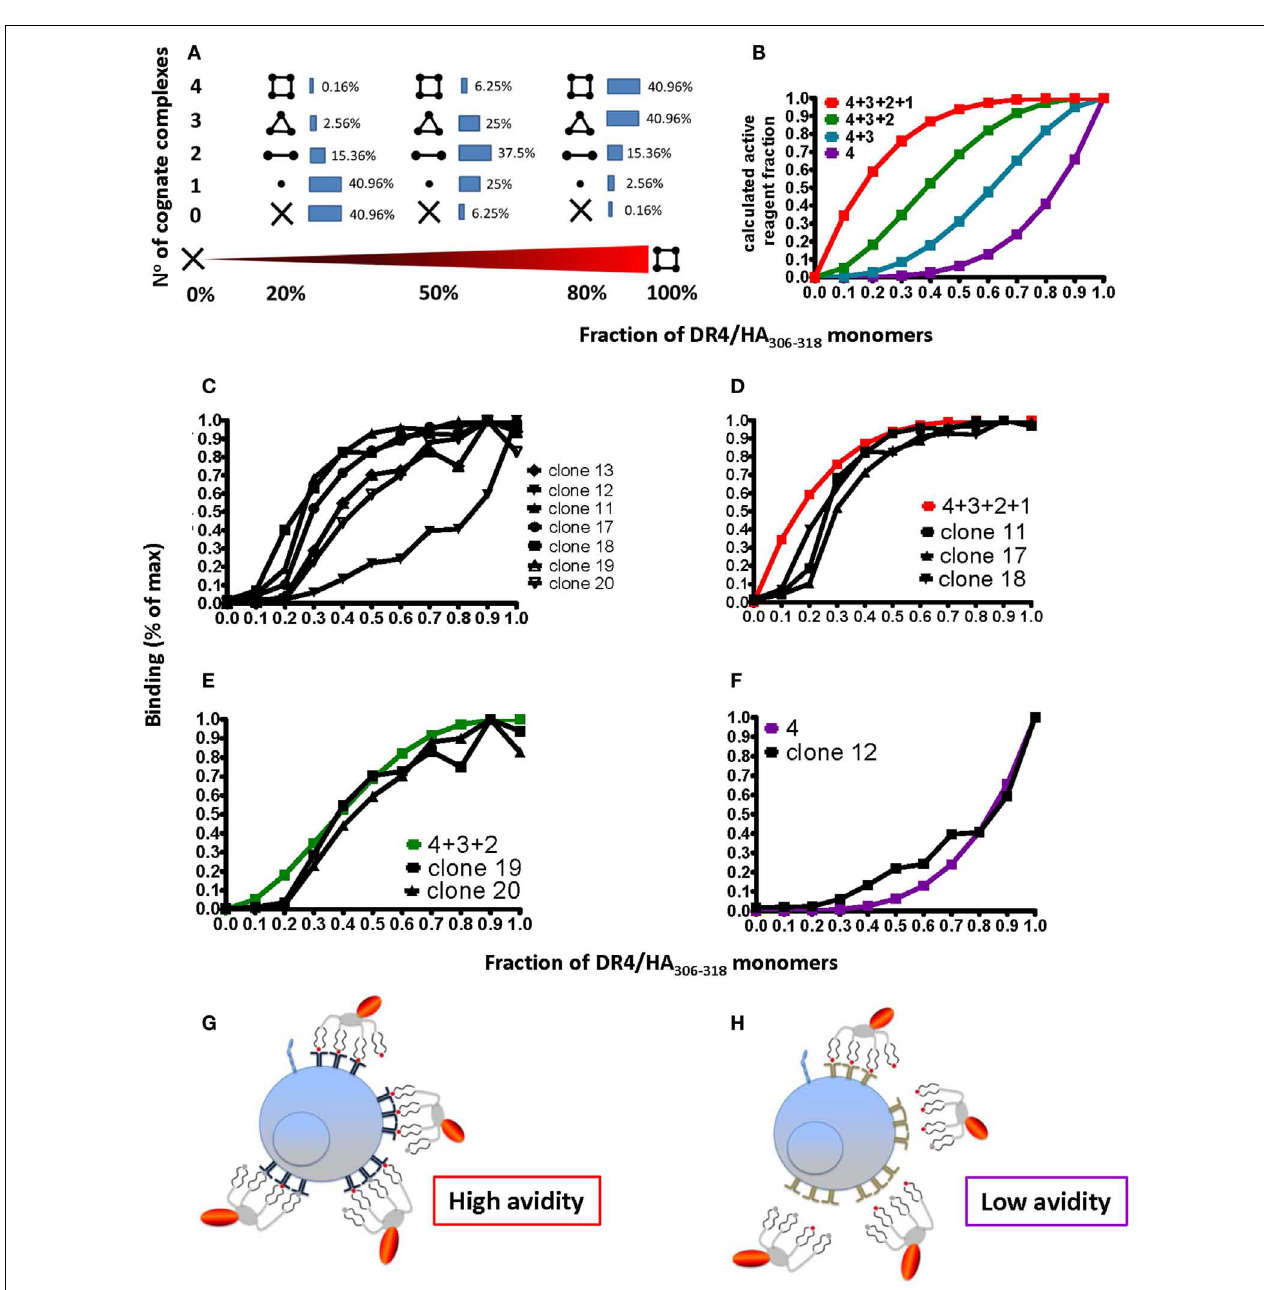
four complexes bind; green: three; blue: two; and purple: one). (C) Seven DR4/HA 306–318 -specific CD4 + T cell clones were incubated with 18.5nM DR4 tetramers with DR4 tetramers containing the indicated factions of HA 306–318 and CLIP peptides ( x -axis; fraction of one) for 1h at 37°C and cell-associated fluorescence assessed by flow cytometry and expressed in % of maximal binding ( y -axis). (D–F) From these binding isotherms those observed on the clones 11, 17, and 18 match the high avidity binding curve (in red) (D) , those recorded on the clones 19 and 20, match the green curve (E) and the one measured on the clone 12 the purple curve (F) . (G,H) The cartoon representation of high (G) and low avidity (H) CD4 + T cells as defined by their ability to bind mixed